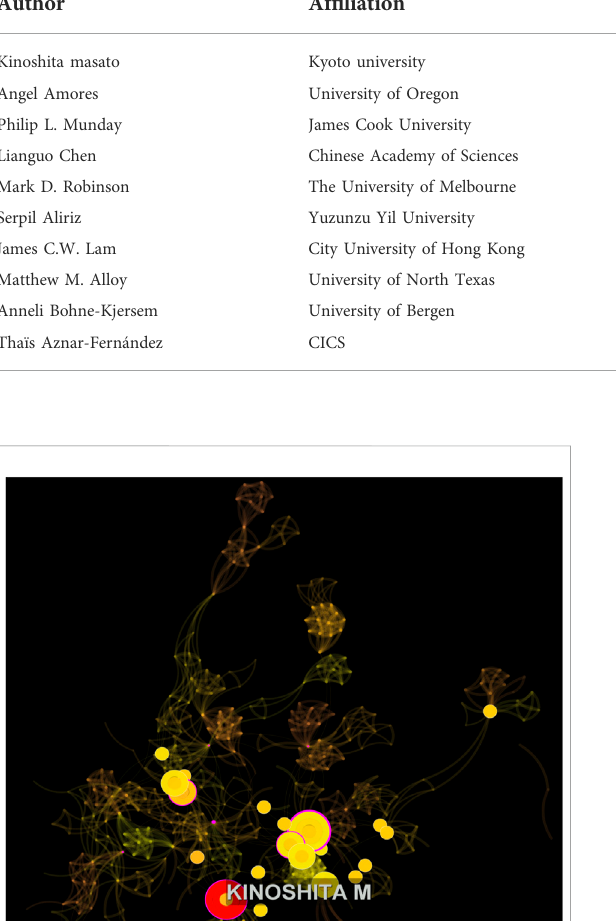
FIGURE 6 Network of Document Co-citation Analysis where articles with a centrality score greater than 0.1 are